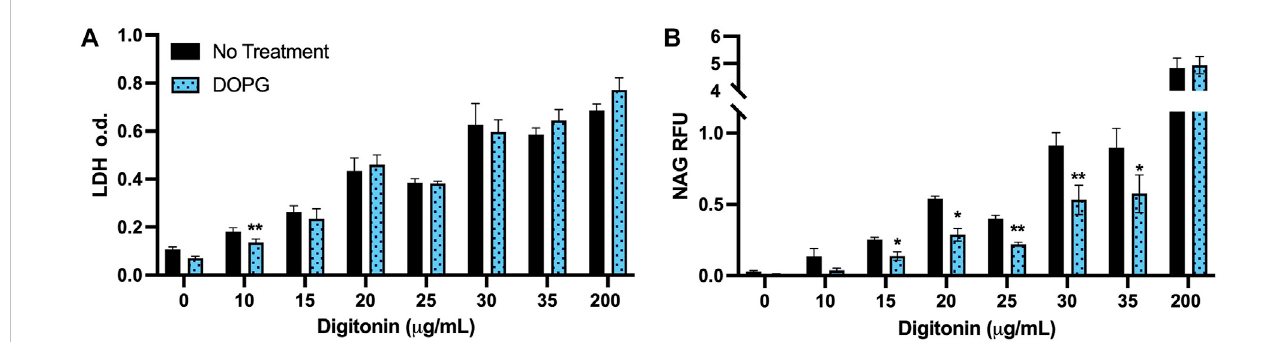
FIGURE 4 DOPG decreases lysosomal susceptibility to digitonin extraction. BMdM were titrated with digitonin (0 – 200 μ g/mL) for 15 min on ice. (A) LDH optical density and (B) NAG relative fl uorescence weremeasuredin cytosolic extracts. Data expressedas mean ± SEM , n = 3. Analyzed bypaired t -test, * p < 0.05 and ** p < 0.01, between untreated and DOPG treated BMdM at respective digitonin concentration.